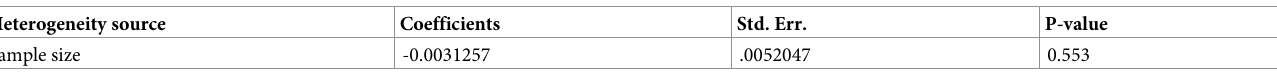
Table 2. Meta-regression analysis of factors affecting between-study